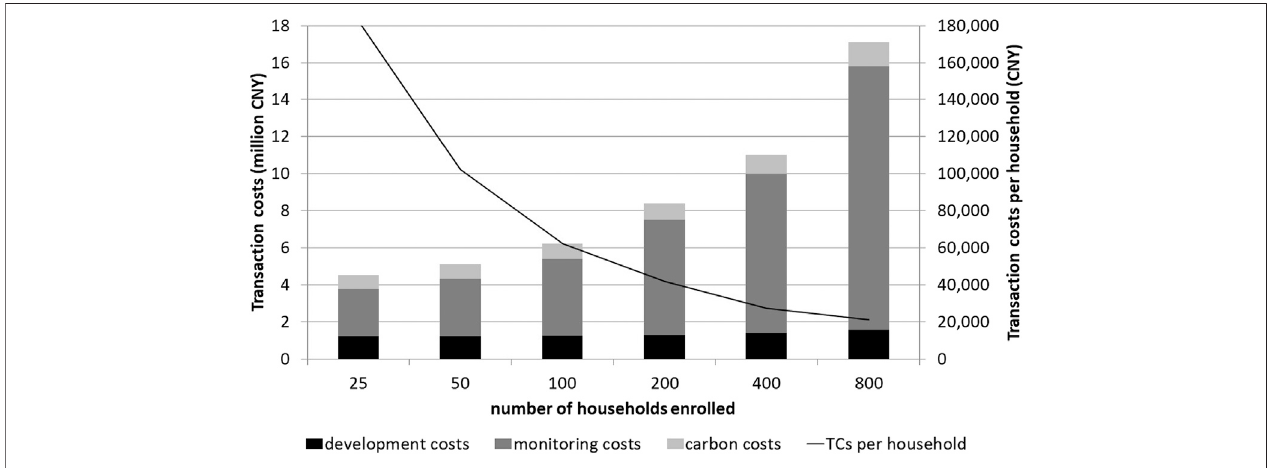
FIGURE 3 | Relationship between project scale and transaction costs (TCs) of a carbon fi nance project (Chinese Yuan, CNY).